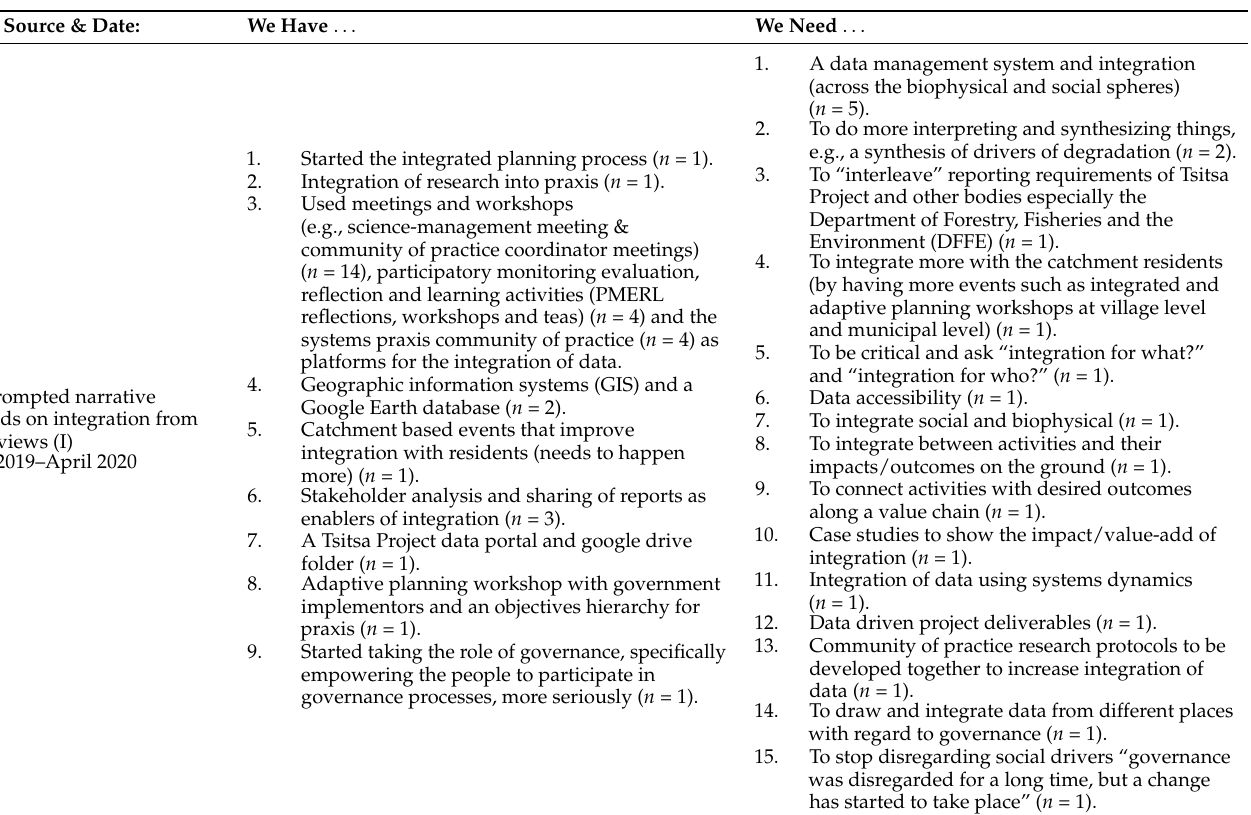
Table 2. Data reported on ‘Integration’ during various phases of the participatory self-observation process in the Tsitsa Project. The data were categorized into achievements, placed in the “We have . . . ” column, and gaps placed in the “We need . . . ”